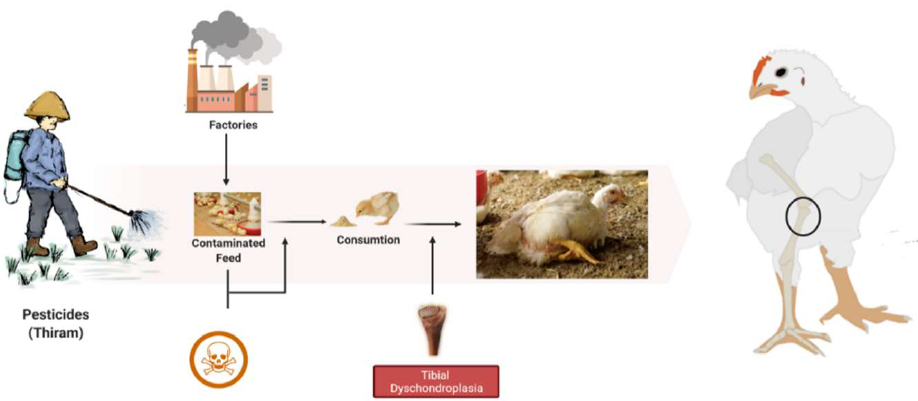
Figure 2. The root cause of tibial dyschondroplasia in broilers.